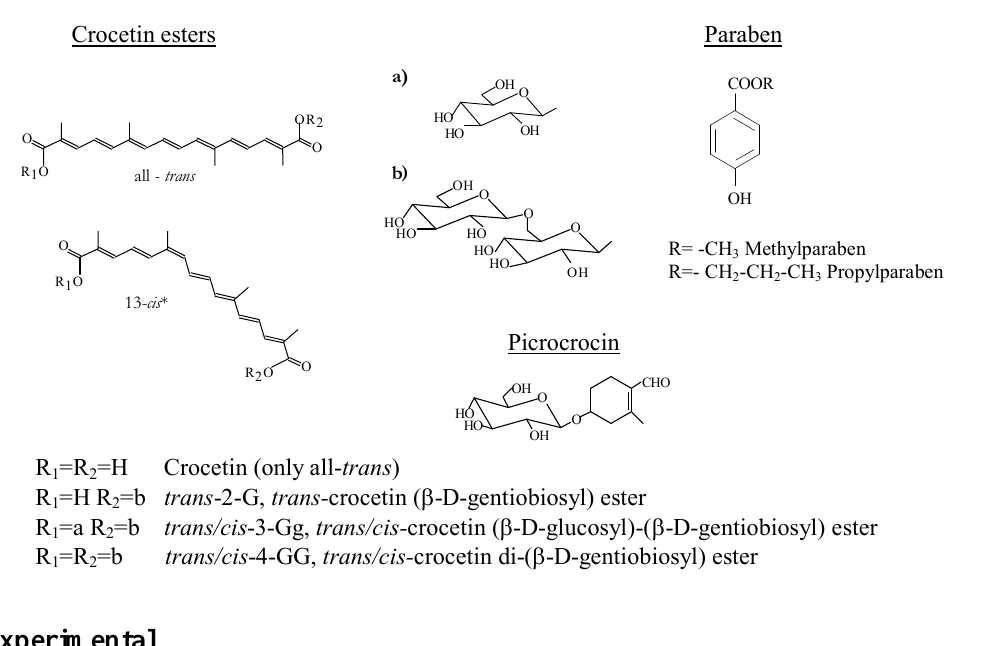
and R could not be exactly 1 2